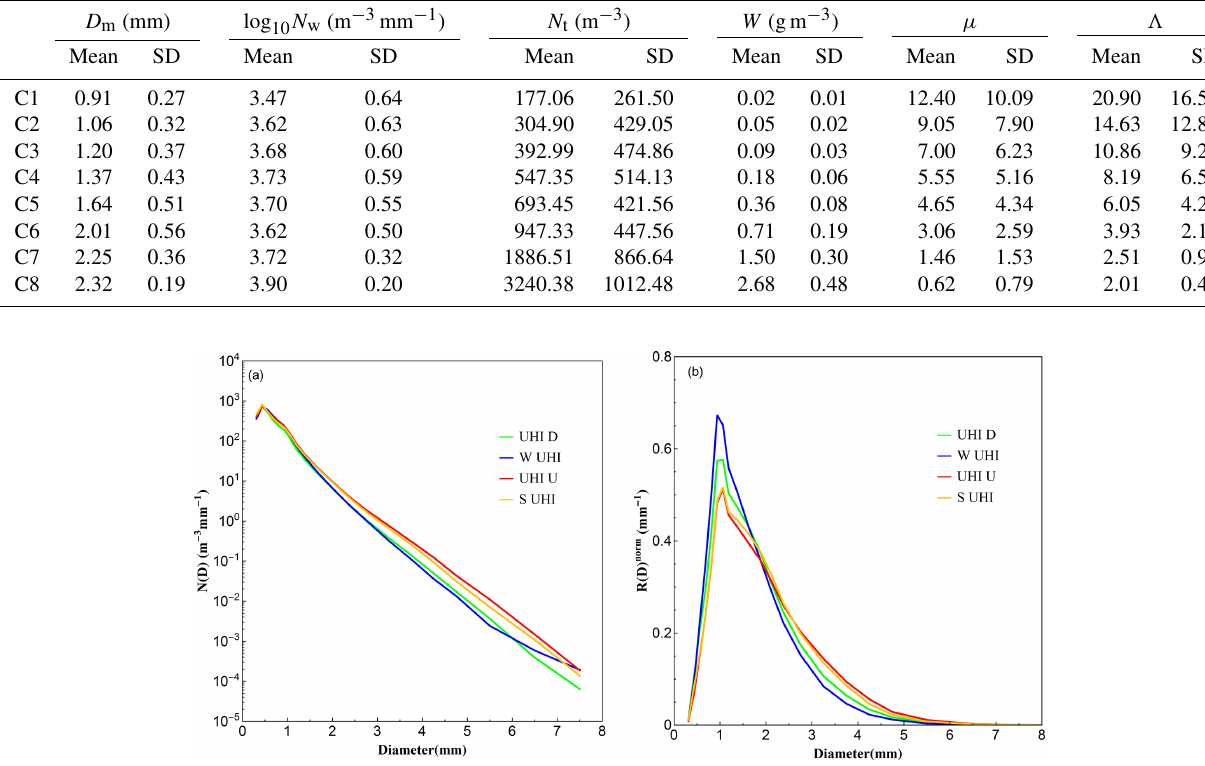
Figure 9. Same as Fig. 6 but for different diurnal periods based on UHI